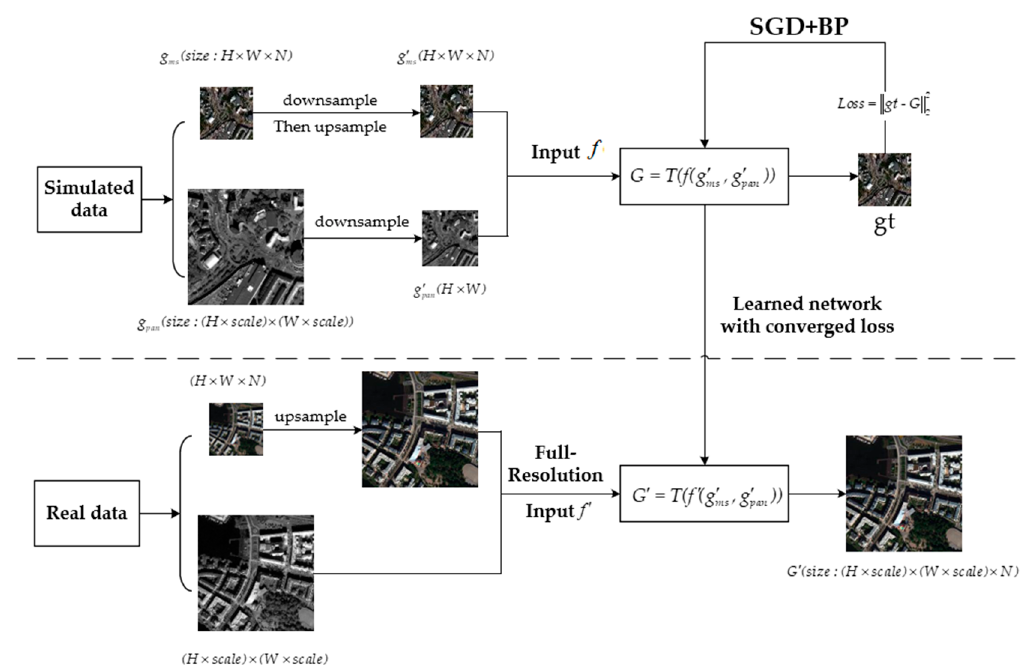
Figure 1. Workflow of the proposed convolutional neural network (CNN)-based pan-sharpening.